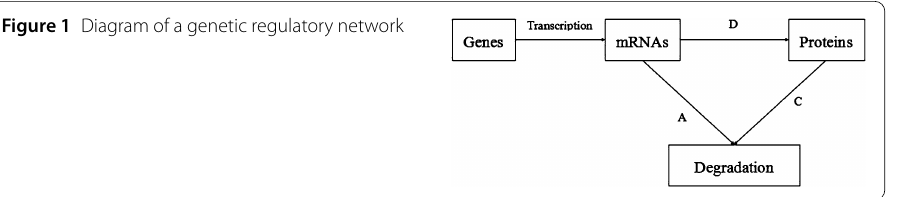
Figure 1 Diagram of a genetic regulatory